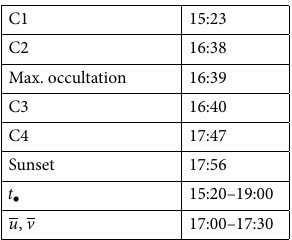
Table 1. ‘Contact’ times of the eclipse of July 2nd, 2019, calculated for La Serena (29°54 W) on http:// xjubi er. free. fr/ en/ and rounded to the nearest minute, in local time (UTC-4). Also given are the time of sunset (calculated on https:// plane tcalc. com/) and time ranges referred to in the text: ‘ t • ’ refers to the times removed from statistical calculations to avoid training data containing effects of the eclipse, and ‘ u , v ’ refers to the time span over which wind data is